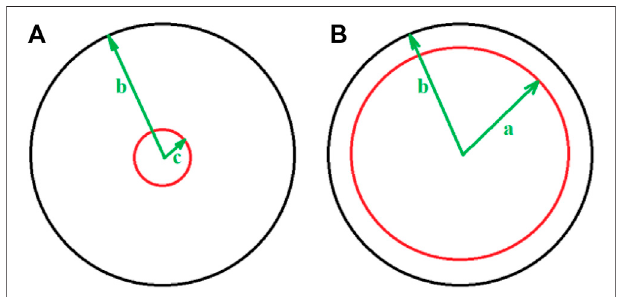
FIGURE 1 | schematic functionality of transformation function that expand (A) virtual region [0, c] to (B) real space [0, a].